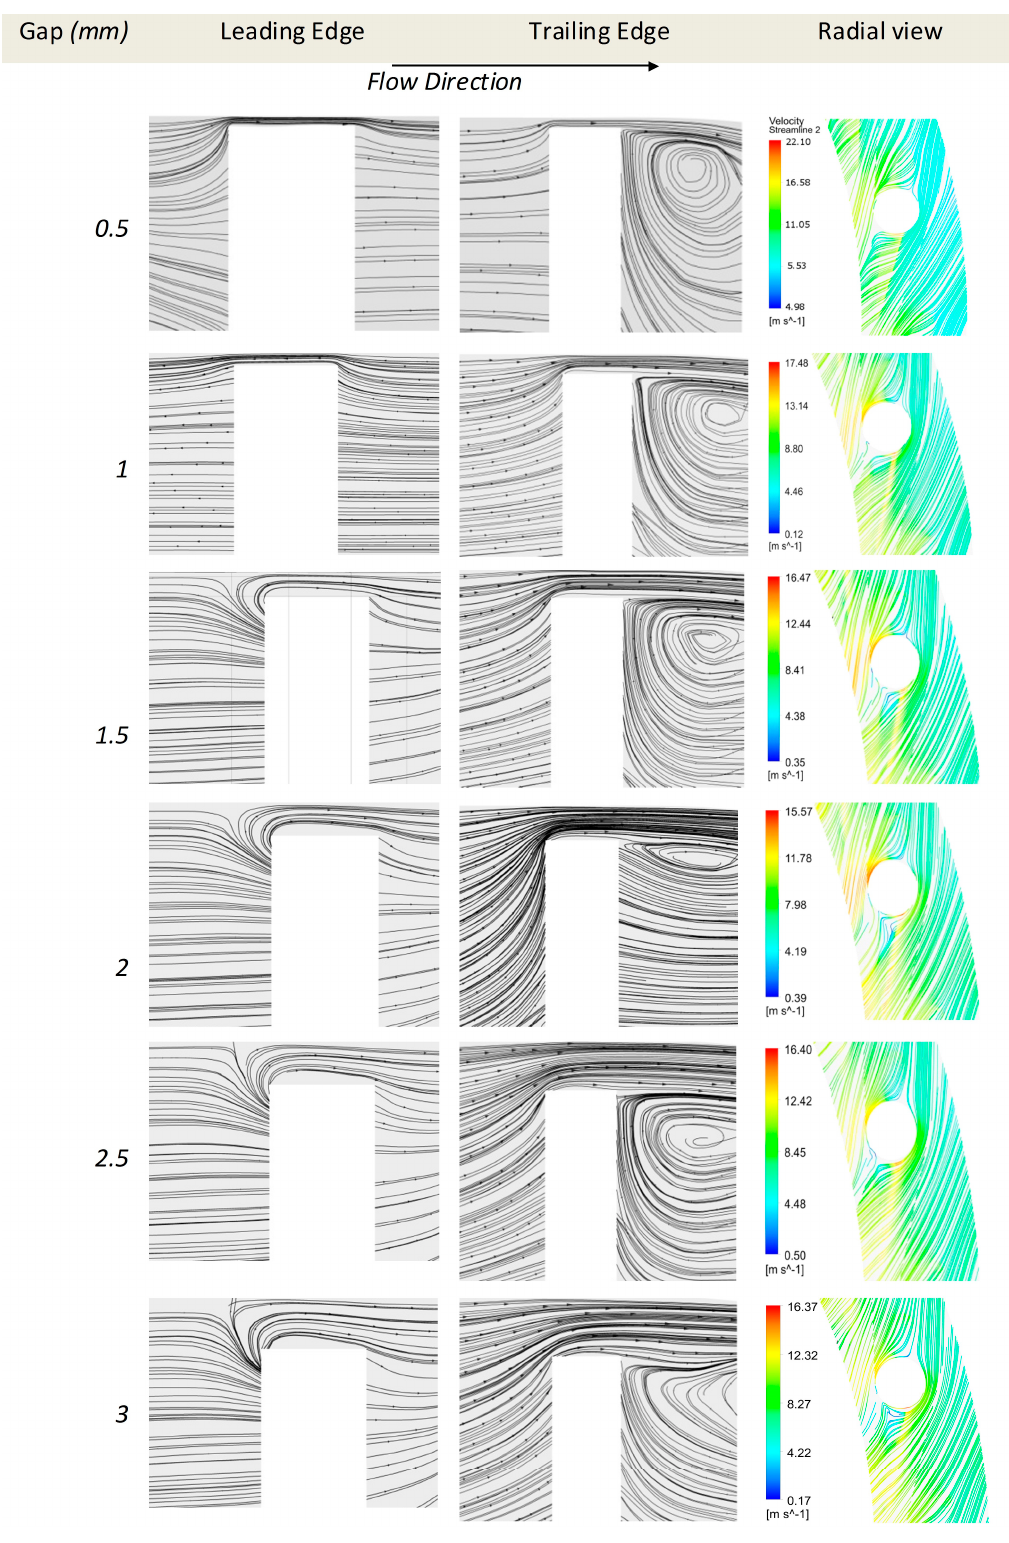
Figure 13. Surface plots at the Leading Edge, Trailing edge and Radial view in the gap.